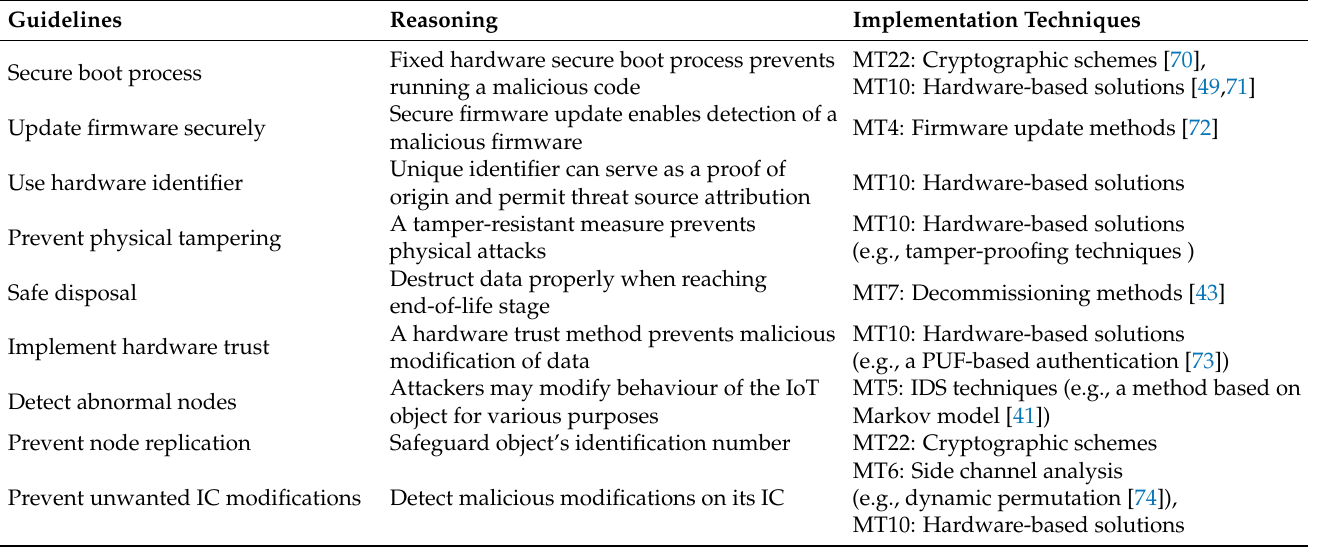
Table 6. A summary of the suggested guidelines for physical layer along with their countermeasures.